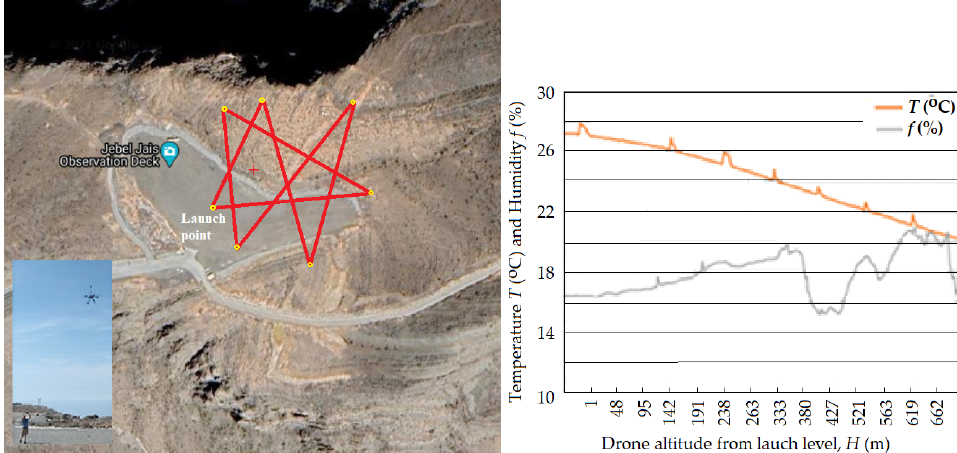
Figure 8. Typical weather drone trajectory over the experimental site and measurements of temper- ature and humidity in artificial updraft and environment.